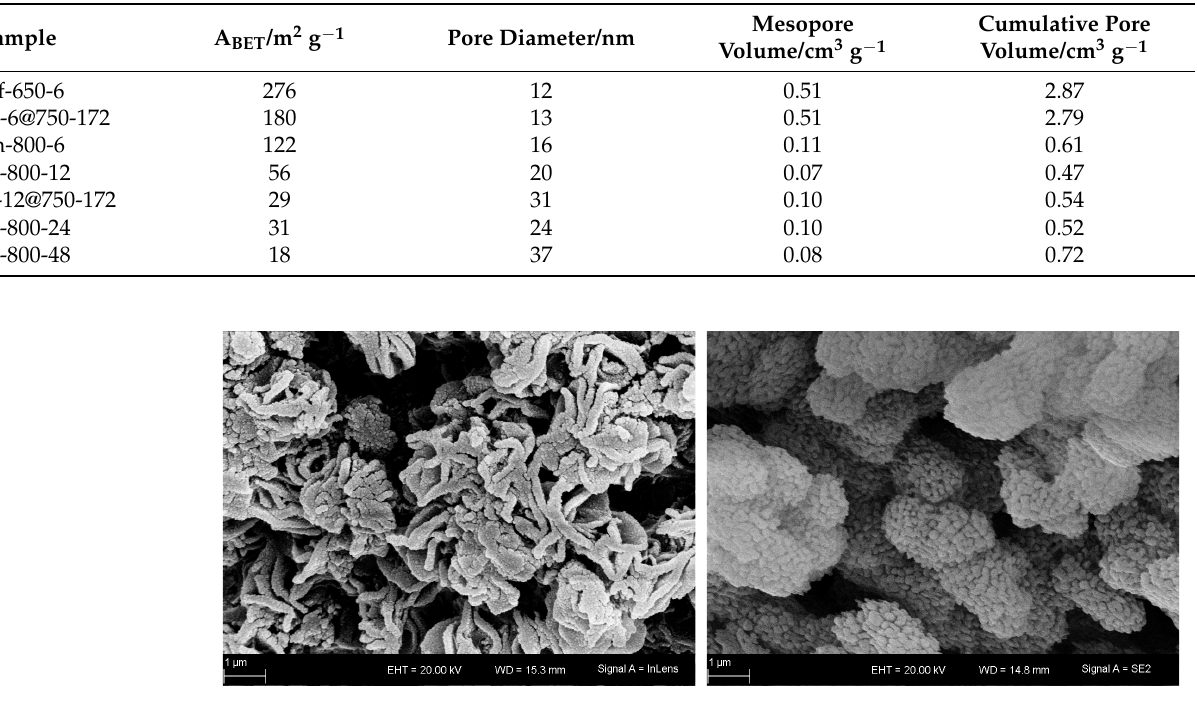
Figure 6. SEM images of samples Mn-800-12 ( left ) and Mn-800-12@750-172 ( right ).